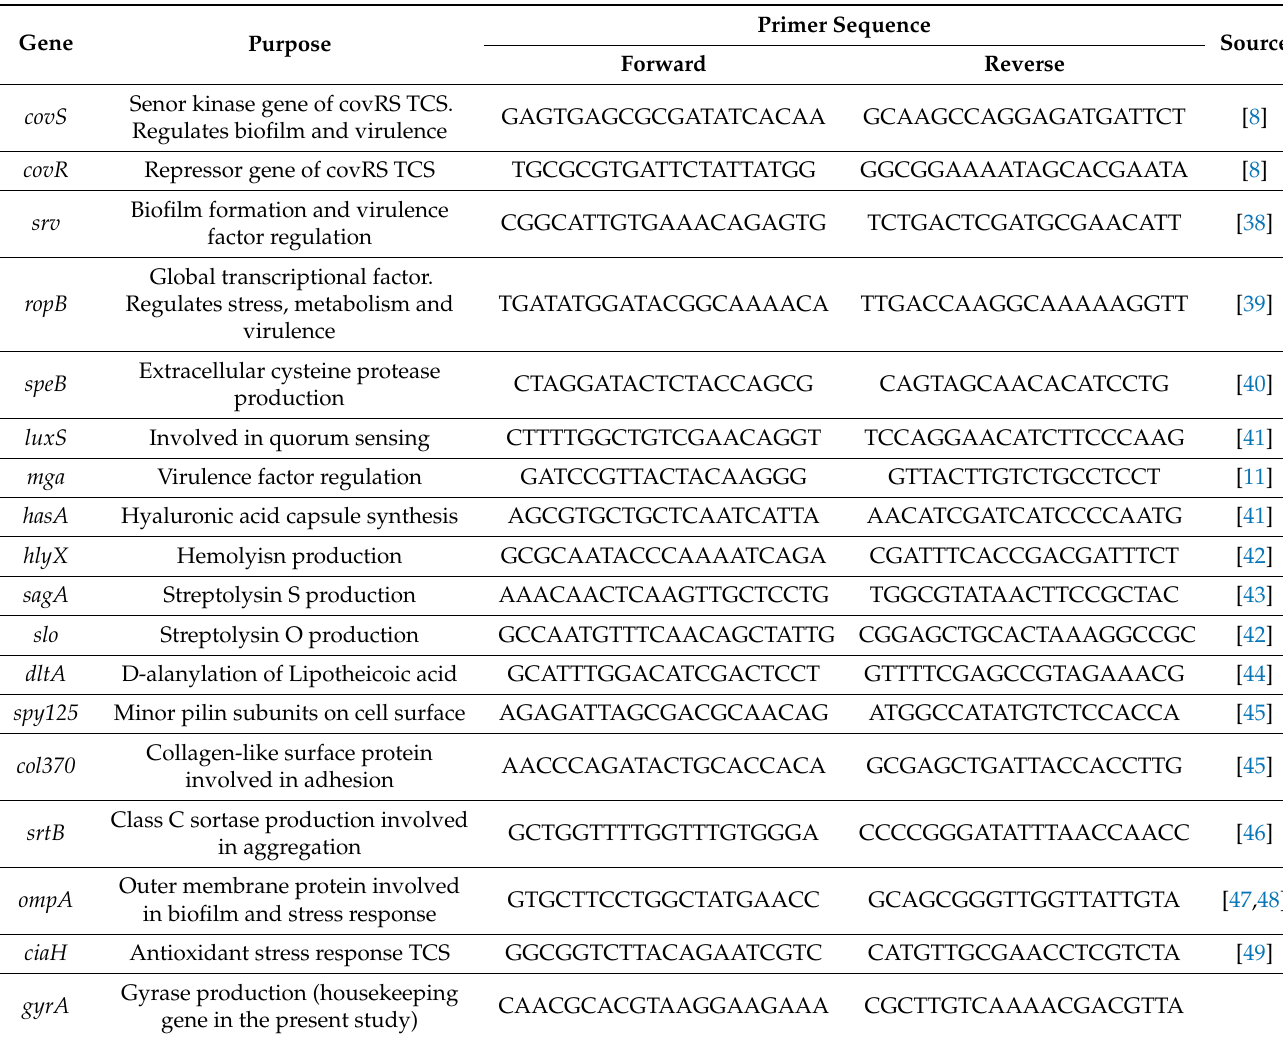
Table 1. Candidate genes, their role and primer